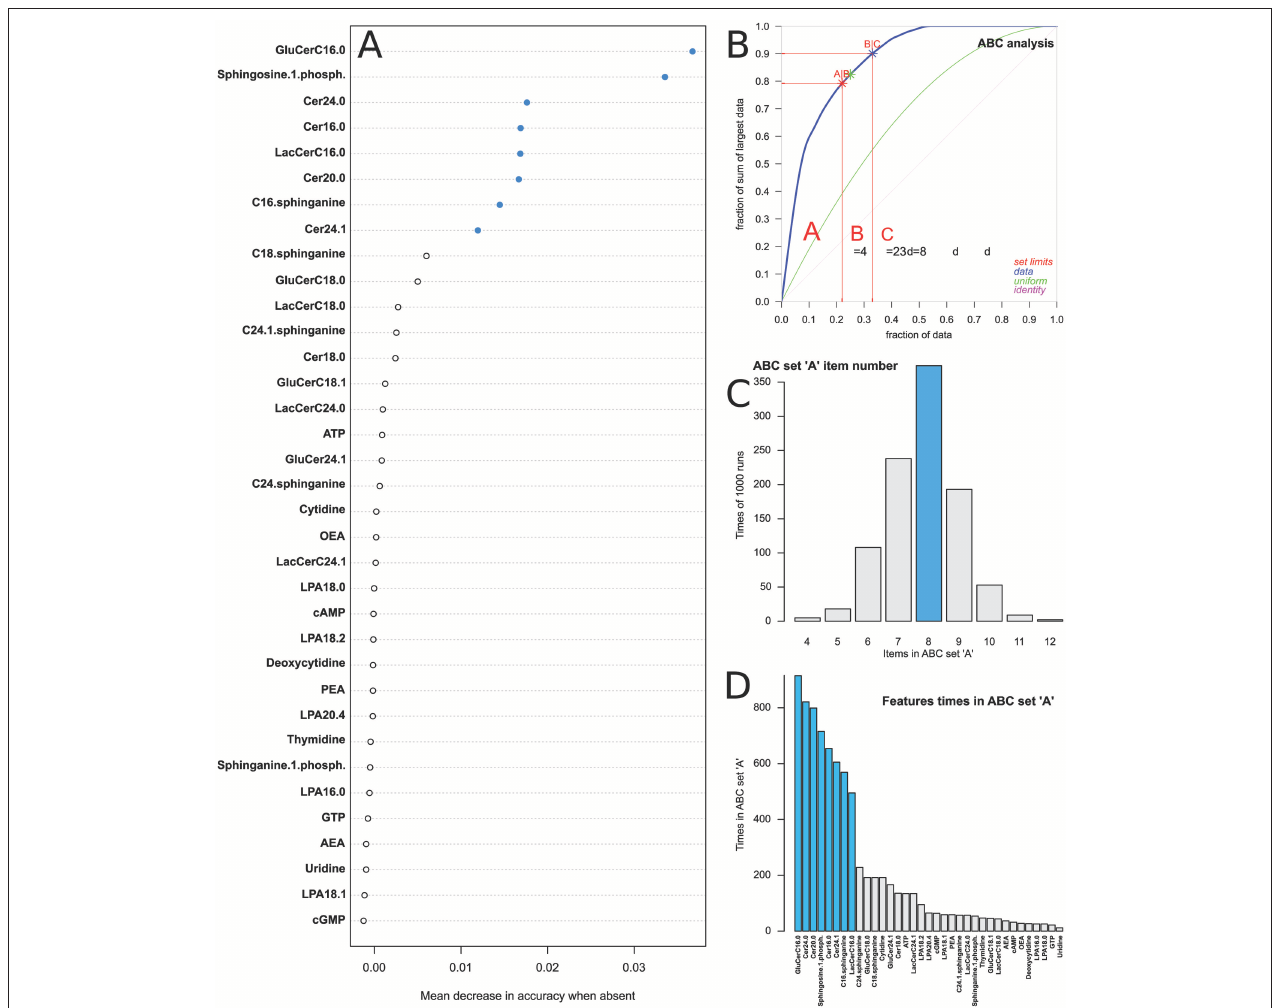
FIGURE 6 | Feature selection based on random forests analysis followed by computed ABC analysis, for the diagnosis of dementia that was consistently identified to display a lipid mediator plasma concentration pattern that differed from that of the other subjects. (A) Display of the mean decrease in classification accuracy when the respective feature (lipid mediator concentration) is excluded from the random forest analysis. The plot displays one typical example out of the analyses of 1,000 bootstrap resampled data subsets. (B) Subsequent to random forest-based feature ranking, the mean decrease in accuracy associated with each item was submitted to computed ABC analysis, which is an item selection procedure aiming at identification of most profitable items from a larger list of items. The ABC plot (blue line) shows the cumulative distribution function of the mean decreases in accuracy, along with the identity distribution, x i = constant (magenta line), i.e., each feature contributes similarly to the classification accuracy [for further details about computed ABC analysis, see (48)]. The red lines indicate the borders between ABC sets “A,” “B,” and “C.” Only set “A” containing the most profitable items was selected as the diagnosis-relevant subsets. (C) Bar plot of the number of lipid mediators found in ABC set A during the 1,000 runs. (D) Bar plot of the features’ importance in descending order of their appearance in ABC set “A” during the 1,000 runs. As set “A” had most frequently a size d = 8, the eighth features (blue bars) found most frequently in set “A” were selected as the most relevant lipid mediators for the diagnosis of dementia in this model. The figure has been created using the R software package [version 3.4.4 for Linux; http://CRAN.R-project.org/; (13)] and our R package “ABCanalysis” [http://cran.r-project.org/package=ABCanalysis;